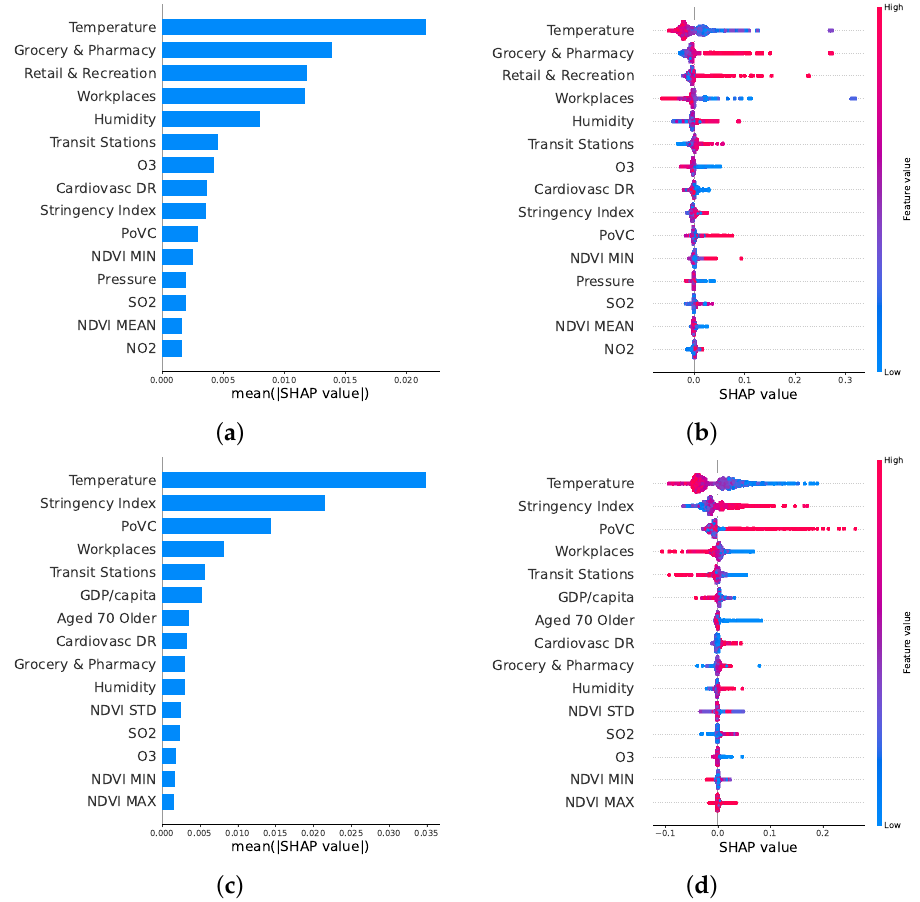
Figure 4. The global aspect of feature understanding using SHAP framework is achieved with the feature importance diagram. In addition to the global explanations, summary plots are adopted as a model interpretation tool for local explanations. Each row corresponds to the model type: the first depicts the cases model while the second depicts deaths. ( a ) SHAP feature importance for cases; ( b ) SHAP summary plot for cases; ( c ) SHAP feature importance for deaths; ( d ) SHAP summary plot for